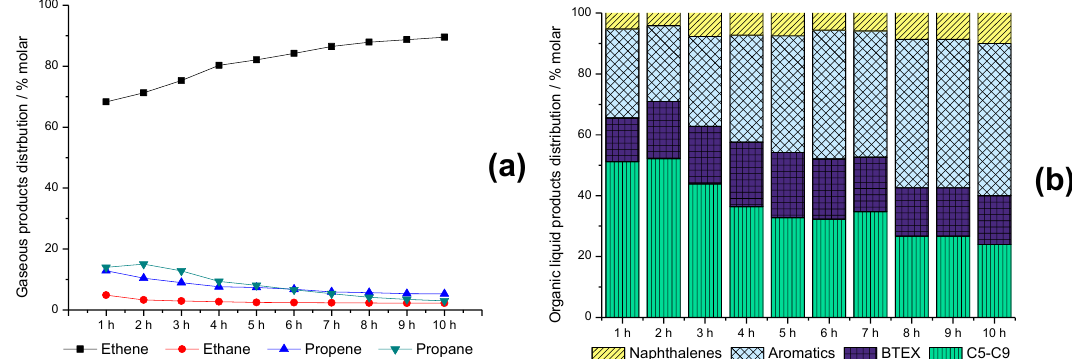
Figure 10. Product class distribution of the ( a ) gaseous fraction and ( b ) organic liquid fraction, for 375 °C, 10 bar, ~70 h − 1 , and 10 h TOS catalyst stability test.